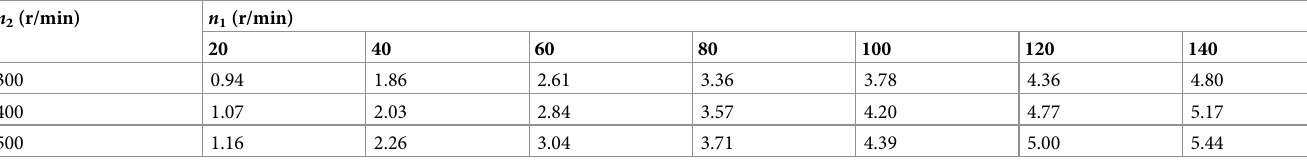
Table 8. Soybean productivity of scheme 4-6(t/h).